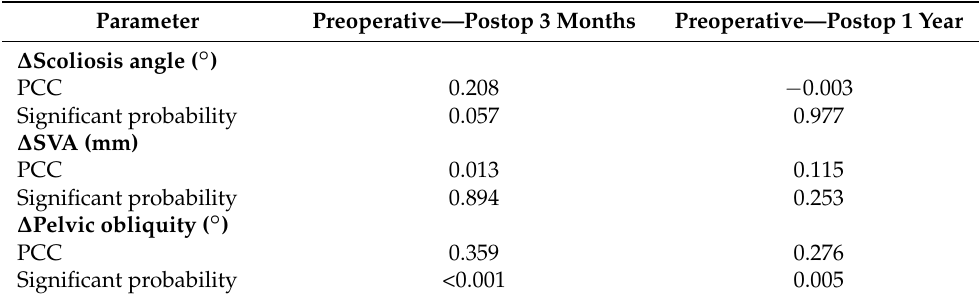
Table 2. Correlation analysis between coronal ∆ HKA Rt-Lt angle and other